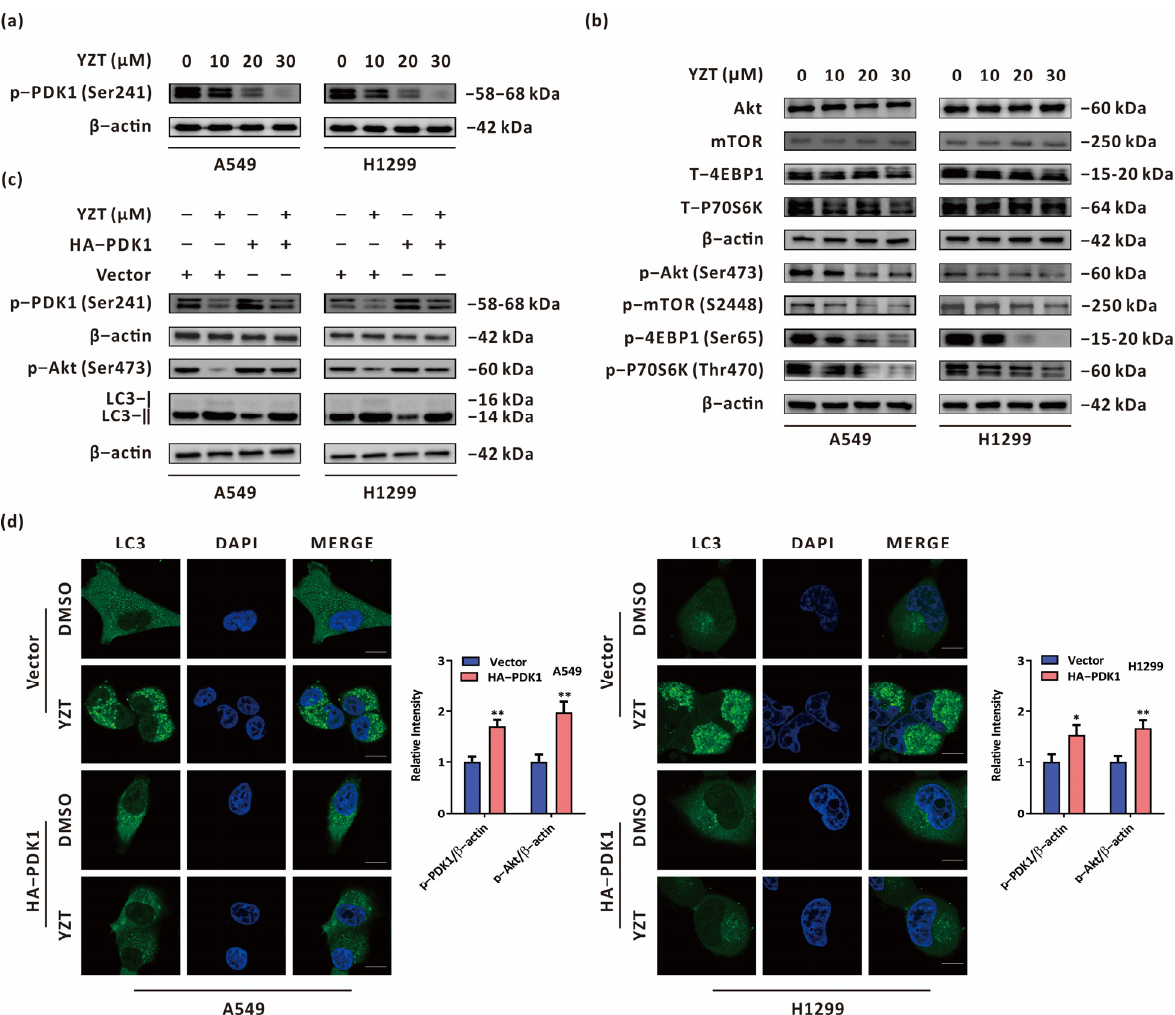
Figure 6. Compound YZT induces autophagy by negatively regulating the PDK1/Akt pathway. ( a ) The level of p-PDK1(Ser241) was detected by immunoblot. ( b ) The levels of p-Akt(Ser473), p-mTOR(S2448), p-4EBP1(Ser65) and p-p70S6K(Thr470) were examined by immunoblotting using the respective total protein levels as the internal controls. ( c ) Immunoblot analysis showed that PDK1 overexpression antagonized the YZT-mediated decrease in p-PDK1(Ser241), p-Akt(Ser473) and the increase in LC3-II. ( d ) Endogenous LC3 puncta were monitored by immunofluorescence. Scale bar: 5 μ m. Significant differences were designated as * p < 0.05, ** p < 0.01.